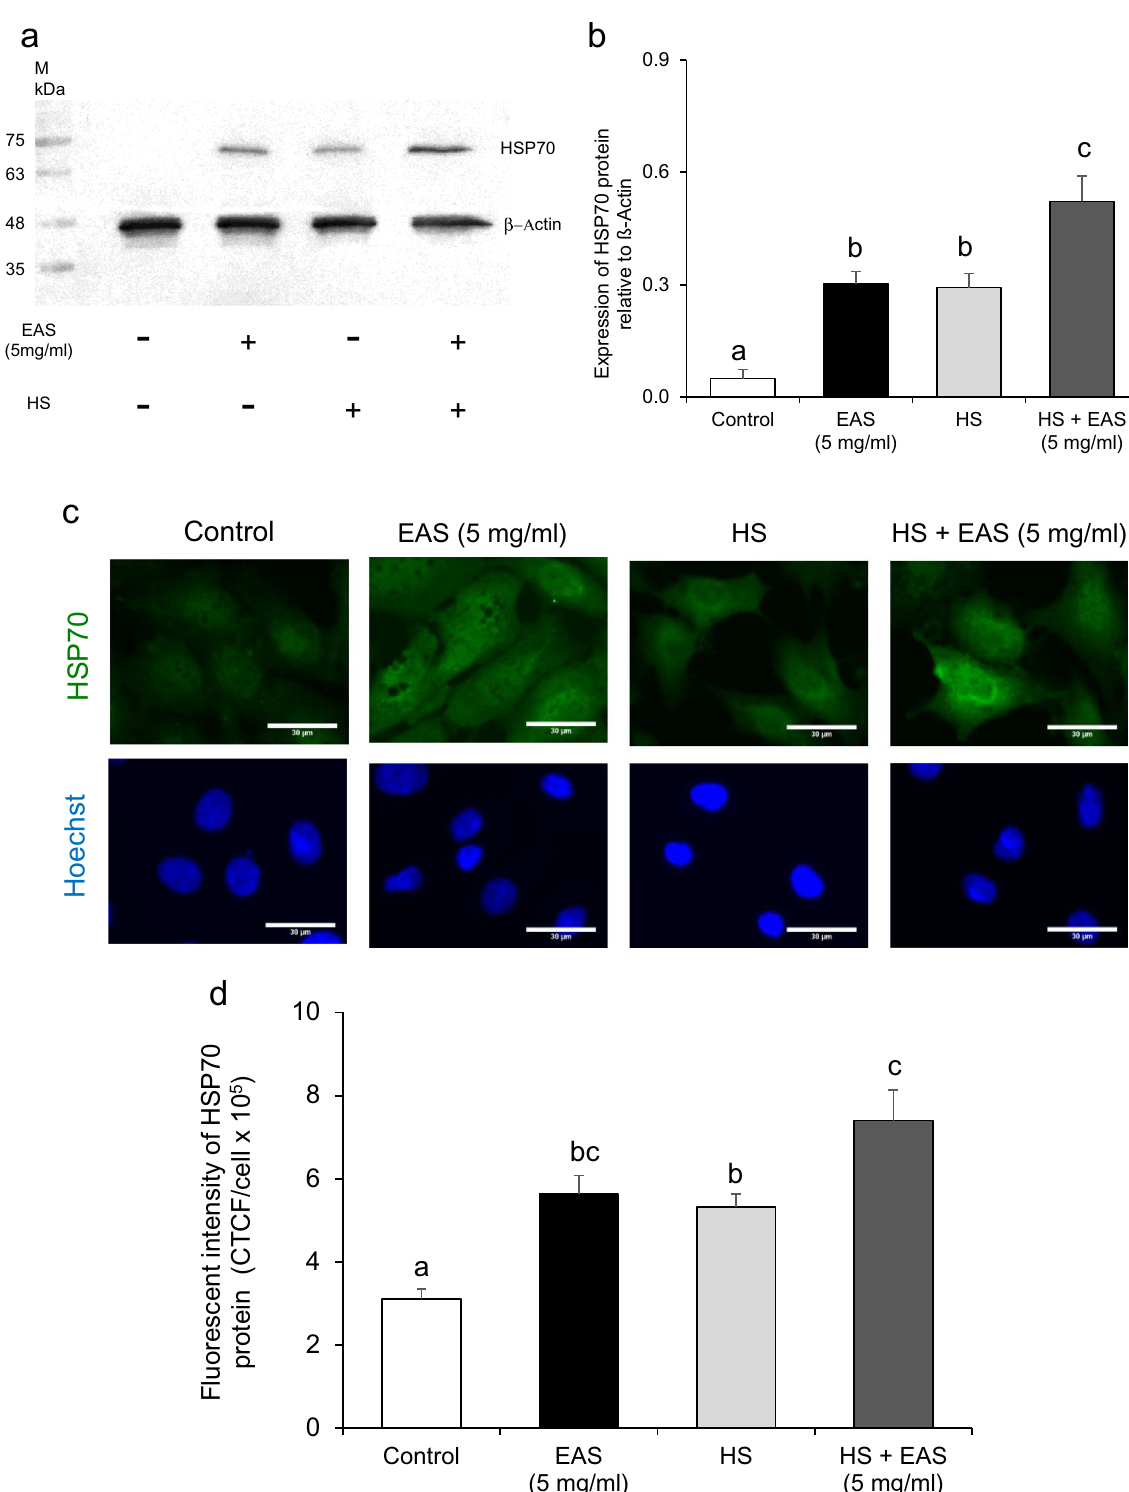
Figure 3. Effect of EAS on the expression of HSP70 protein in bovine CG cells. Cells were treated for 6 h with or without EAS (5 mg/ml) under normal conditions at 38.5 °C (control, EAS group) and HS conditions at 41 °C (HS, HS + EAS group). ( a ) Western blotting to elucidate the expression profile of HSP70 (upper bands) and β-actin (lower bands). Left lane shows the molecular marker from 35 to 75 kDa. ( b ) The expression level of HSP70 protein was normalized to that of β-actin. ( c ) Immunostaining for HSP70, Hoechst, and HSP70 Immunostaining images are shown at magnification × 40, and the scale bar is 30 μm. ( d ) Bars showing CTCF analysis of fluorescence intensity. ( a ) Data are shown as the mean ± SEM, n = 3, a vs. b ( P < 0.05), a vs. c ( P < 0.01), and b vs. c ( P < 0.05). ( d ) Data are shown as the mean ± SEM, n = 5, a vs. b ( P < 0.05), a vs. c ( P < 0.01), and b vs. c ( P <